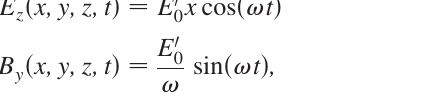
FIG. 15. Axial electric field (blue traces) behind a 1-nC bunch with Gaussian (a) and linearly ramped (b) current profiles (the bunch profiles are shown as red traces). In our convention E corresponds to a decelerating field. For both cases the bunch is centered at (cid:18) ¼ 0 and the head corresponds to (cid:18) > 0 . The transformer ratio quoted in the text is computed as the ratio of